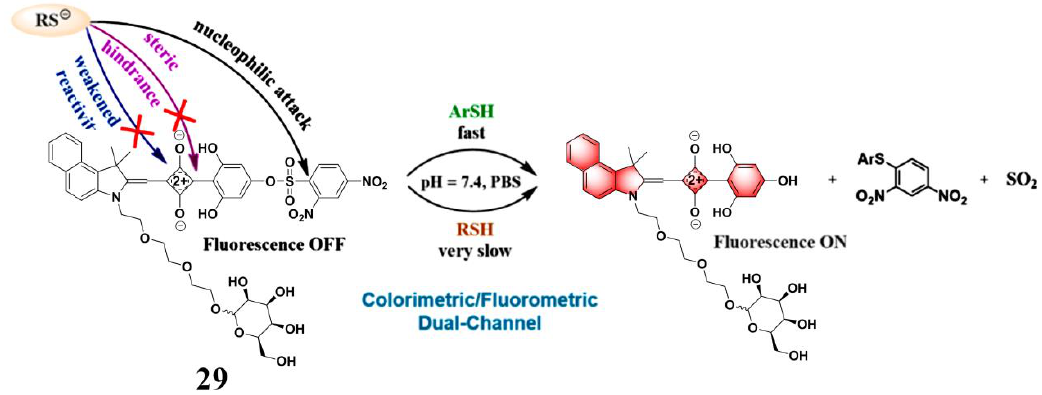
Figure 13. Structure and reaction of probe 29 with PhSH. Reproduced with permission from Reference [93]; copyright American Chemical Society.